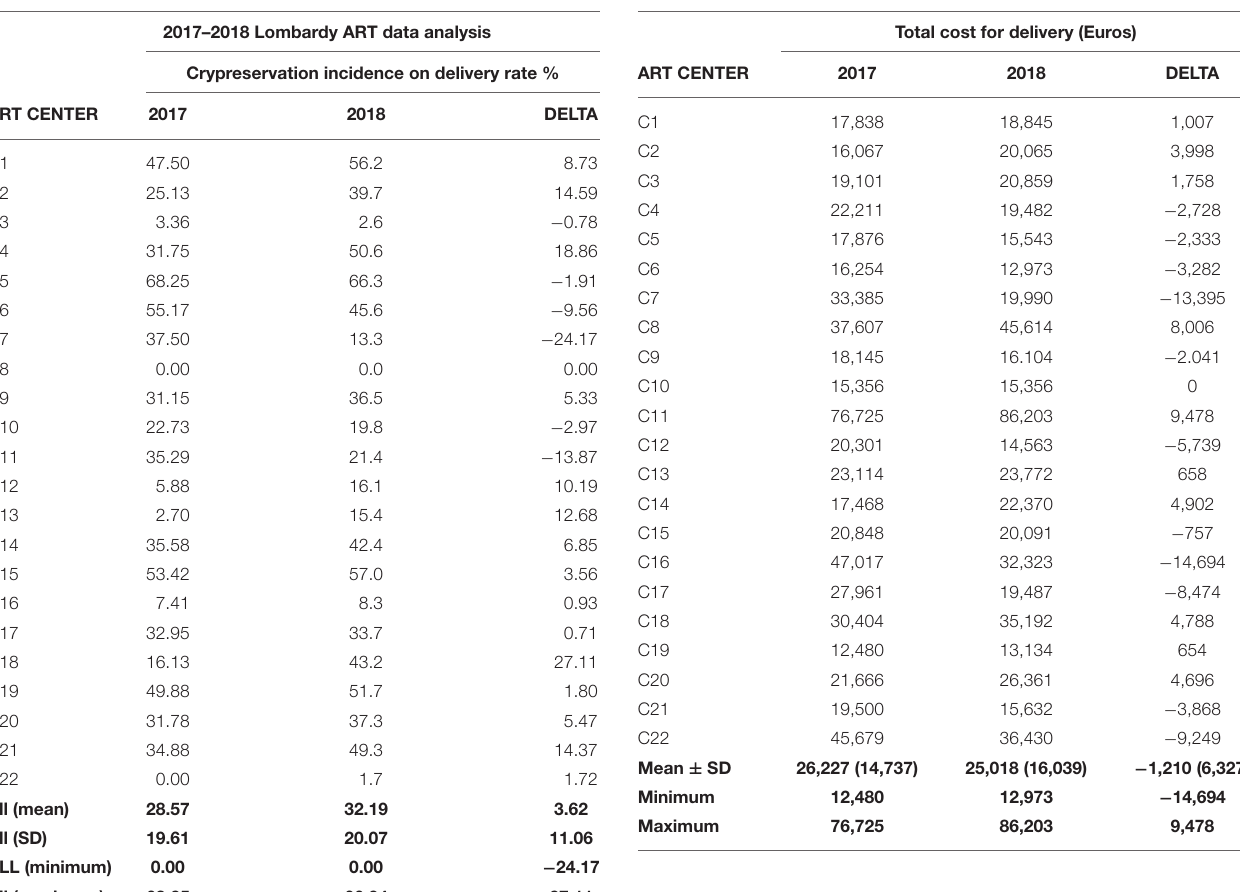
TABLE 6 | Cost for the NHS of delivery in all 22 IVF Centers in the period 2017–2018 (conversion Euro to US dollar